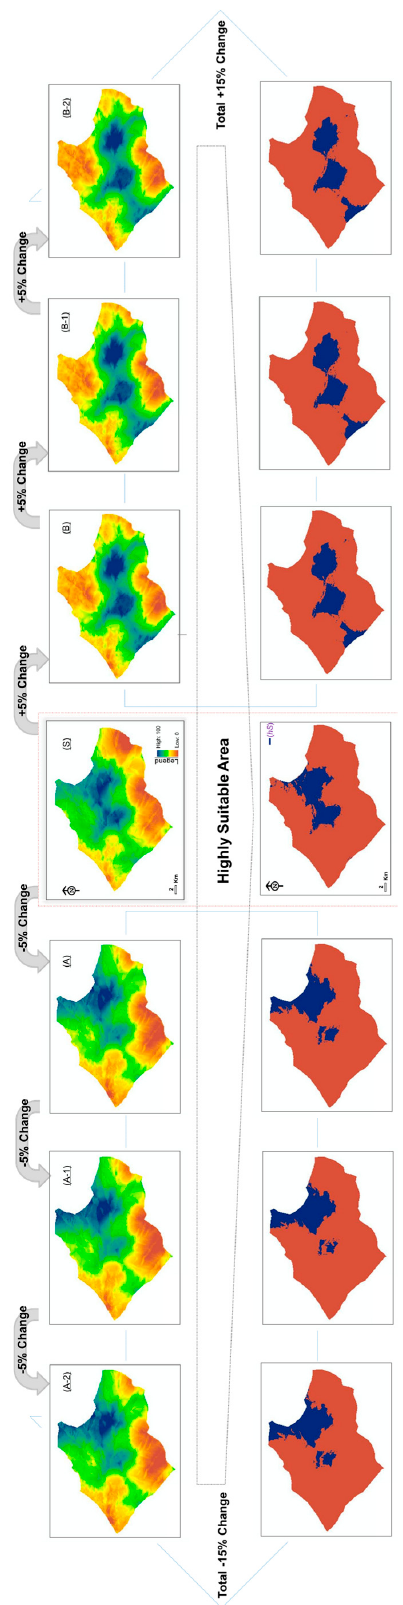
Figure 7. Various sensitivity analysis under continuously changing ±5% variations from final suitability map.